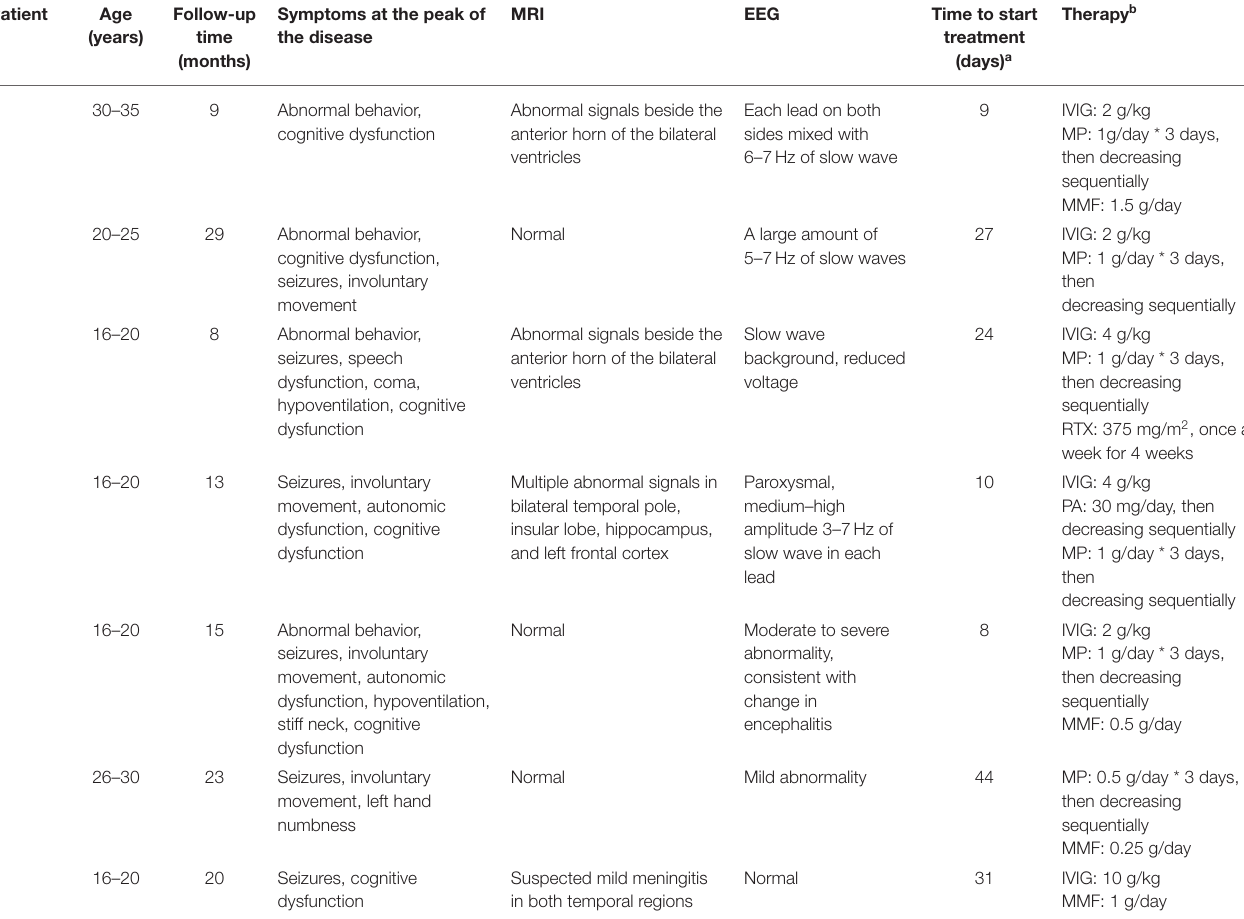
TABLE 2 | Clinical data in part two of the